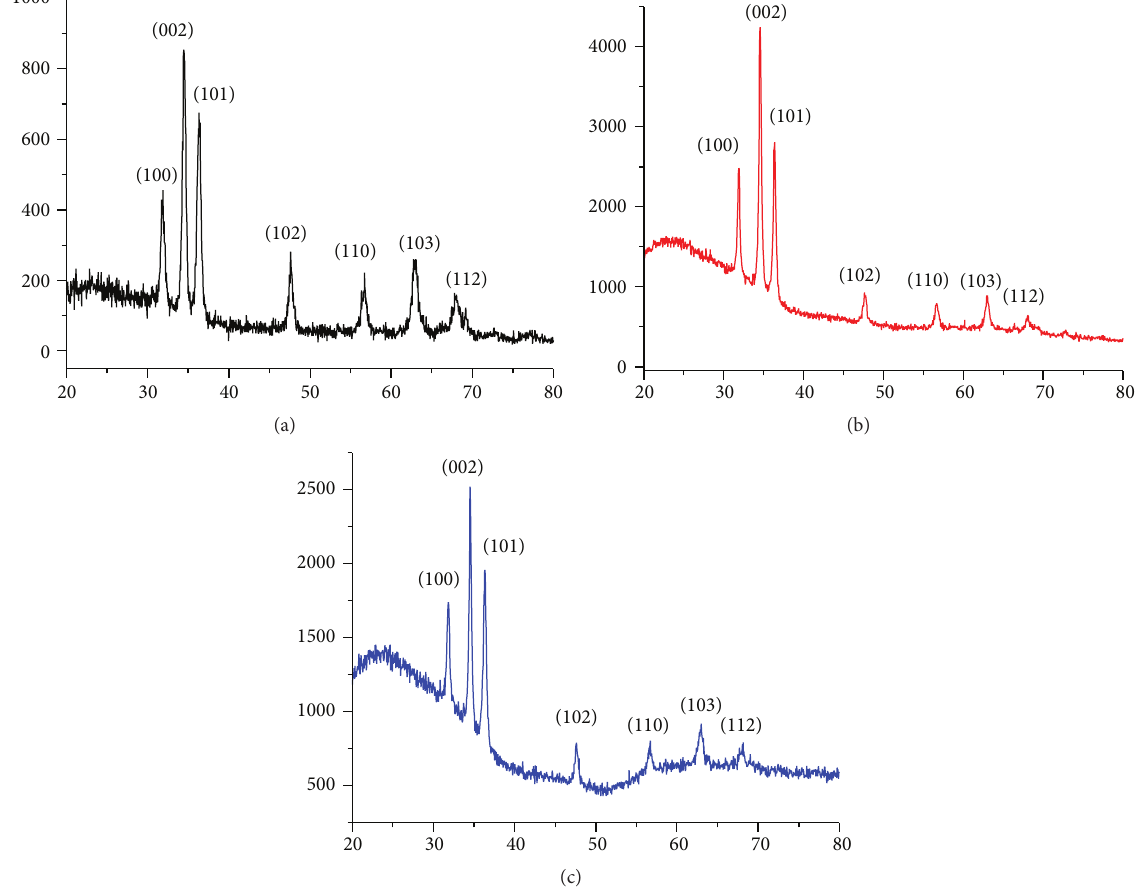
Figure 2: XRD pattern of undoped and Cu doped ZnO thin films sample. Here (a), (b), and (c) correspond to samples Z2, Z2C1, and Z2C2, respectively, prepared using precursor solution of molarity of 0.15